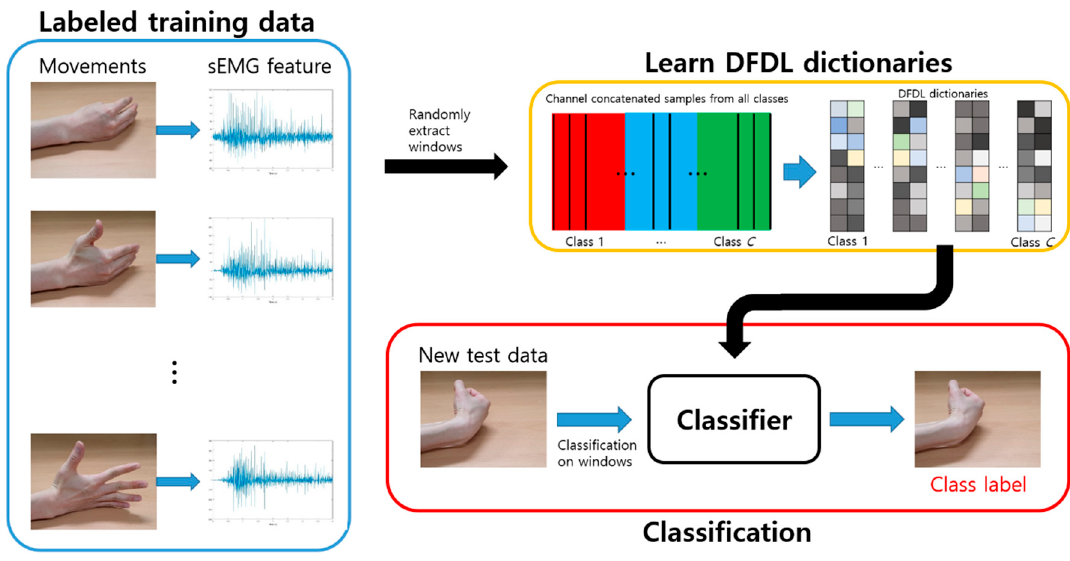
Figure 3. Proposed framework for sEMG classification using discriminative feature-oriented dictionary learning (DFDL).